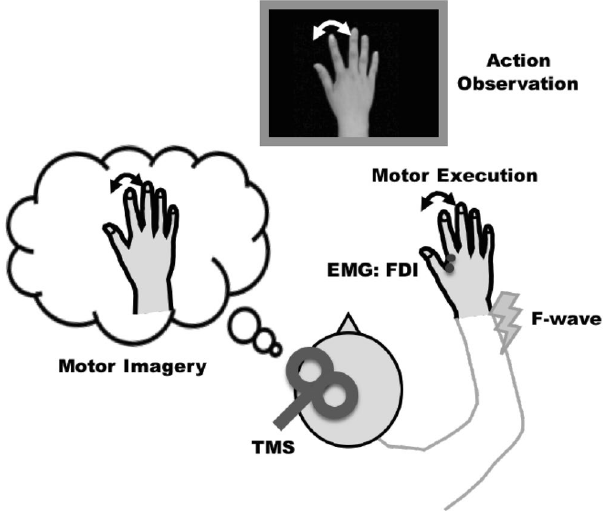
Figure 1. Schematic illustration of the experimental setup in Experiments 1–5. The subjects performed motor imagery (Experiments 1–3) or motor execution task (Experiment 4, 5) of index finger movement while they observed the hand movement. EMG signals were recorded from the FDI muscle. TMS was applied at the left motor cortex in Experiments 1, 4 (single-pulse), and 3, 5 (paired-pulse). In Experiment 2, electrical stimulation was applied to the ulnar nerve at the wrist to induce